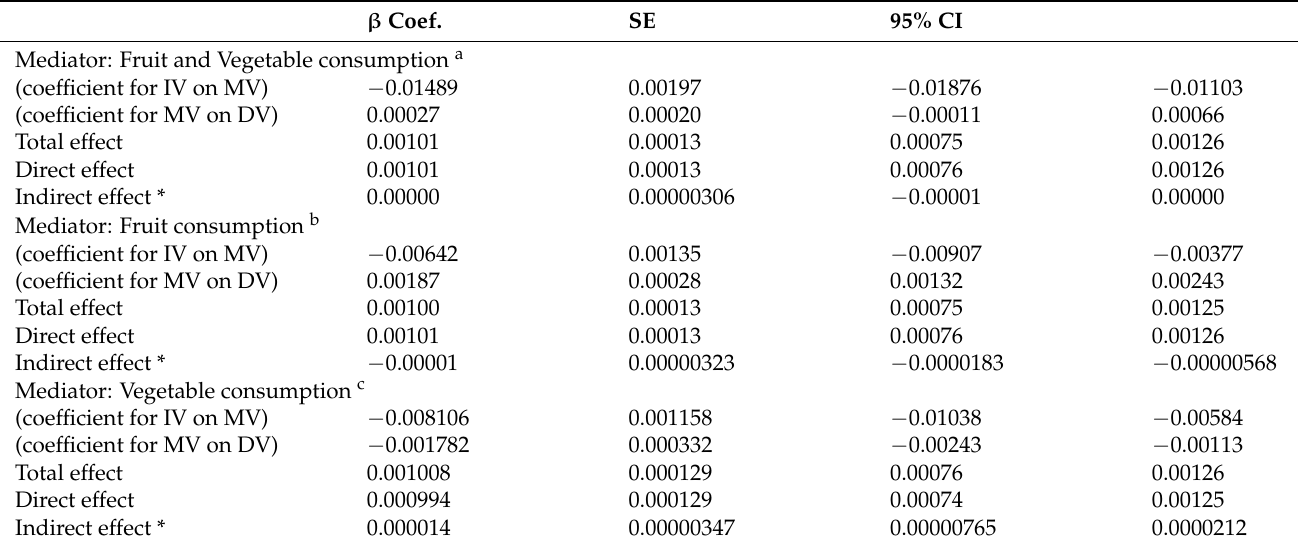
Table 3. Results of mediation analysis exploring fruit and vegetable consumption as mediators in the relationship between local authority unhealthy food sales percentage and